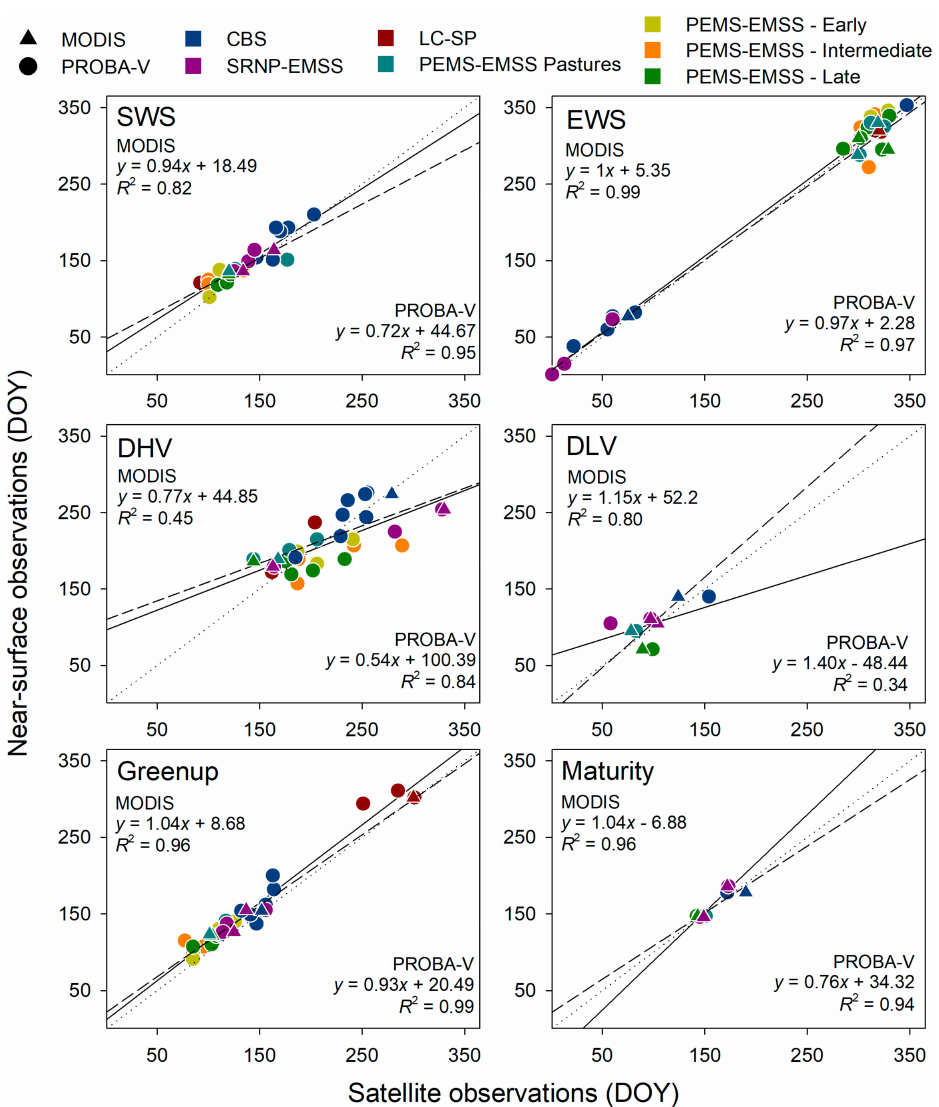
Figure 5. Scatterplot comparing the day of the year (DOY) of phenological events derived from satellite and near-surface observations at four tropical dry forests. The linear relationship between MODIS and near-surface observations is described by the solid lines, while the relationship between PROBA-V and near-surface observations is described by the dashed lines. Start and end of the wet season (SWS, EWS); day of the highest and lowest NDVI values (DHV, DLV). Acronyms for the sites are described on Table